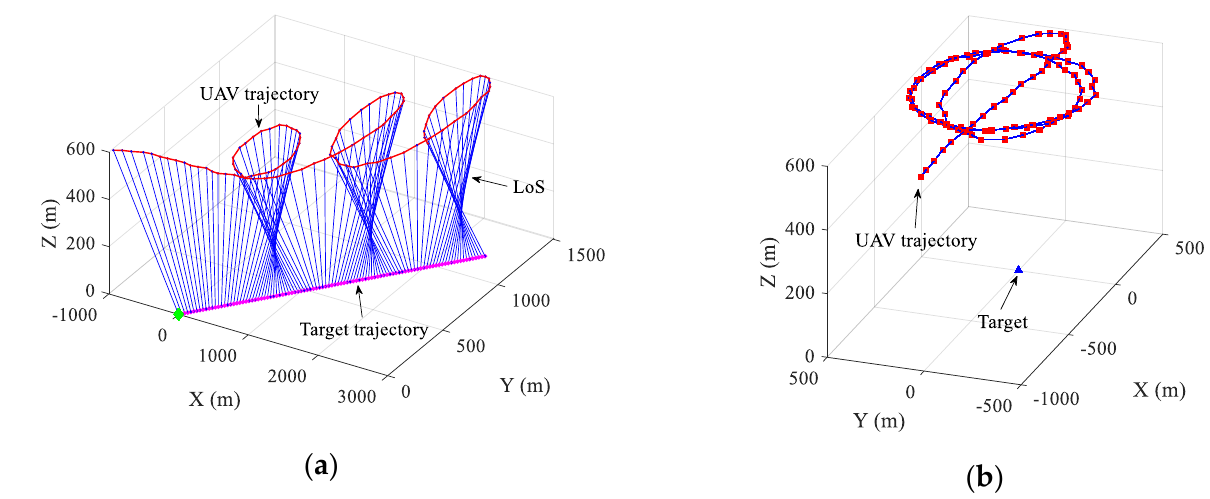
Figure 5. Trajectory optimization result with the constant velocity motion model. ( a ) Absolute trajectory. ( b ) Relative trajectory with target as the